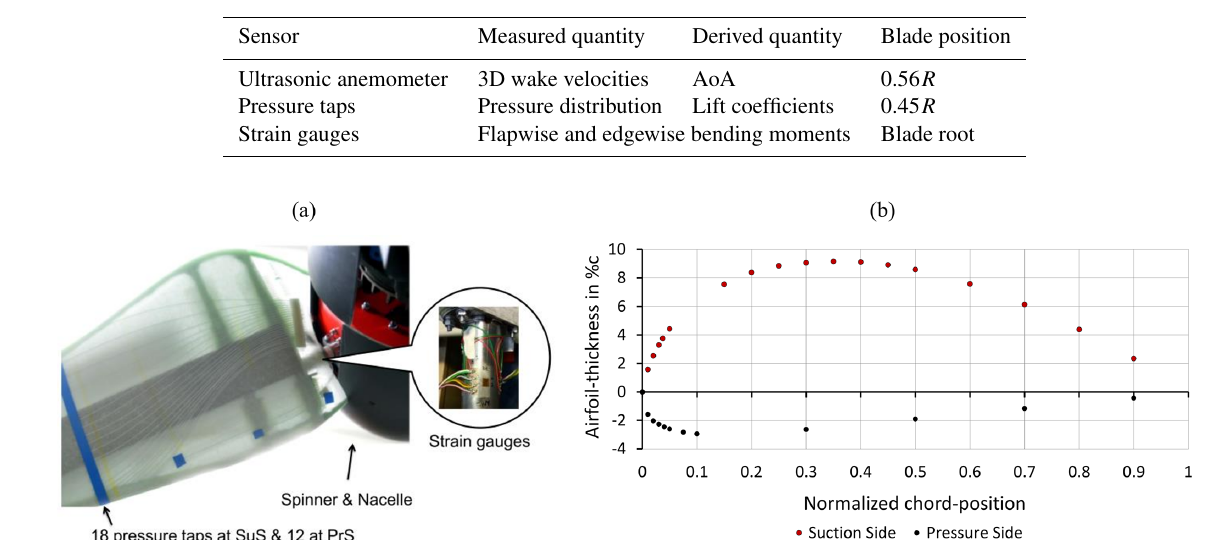
Figure 6. (a) BeRT blade and pressure taps, with permission from SMART BLADE GmbH. (b) Chord-wise position of pressure taps at r = 0.45 R